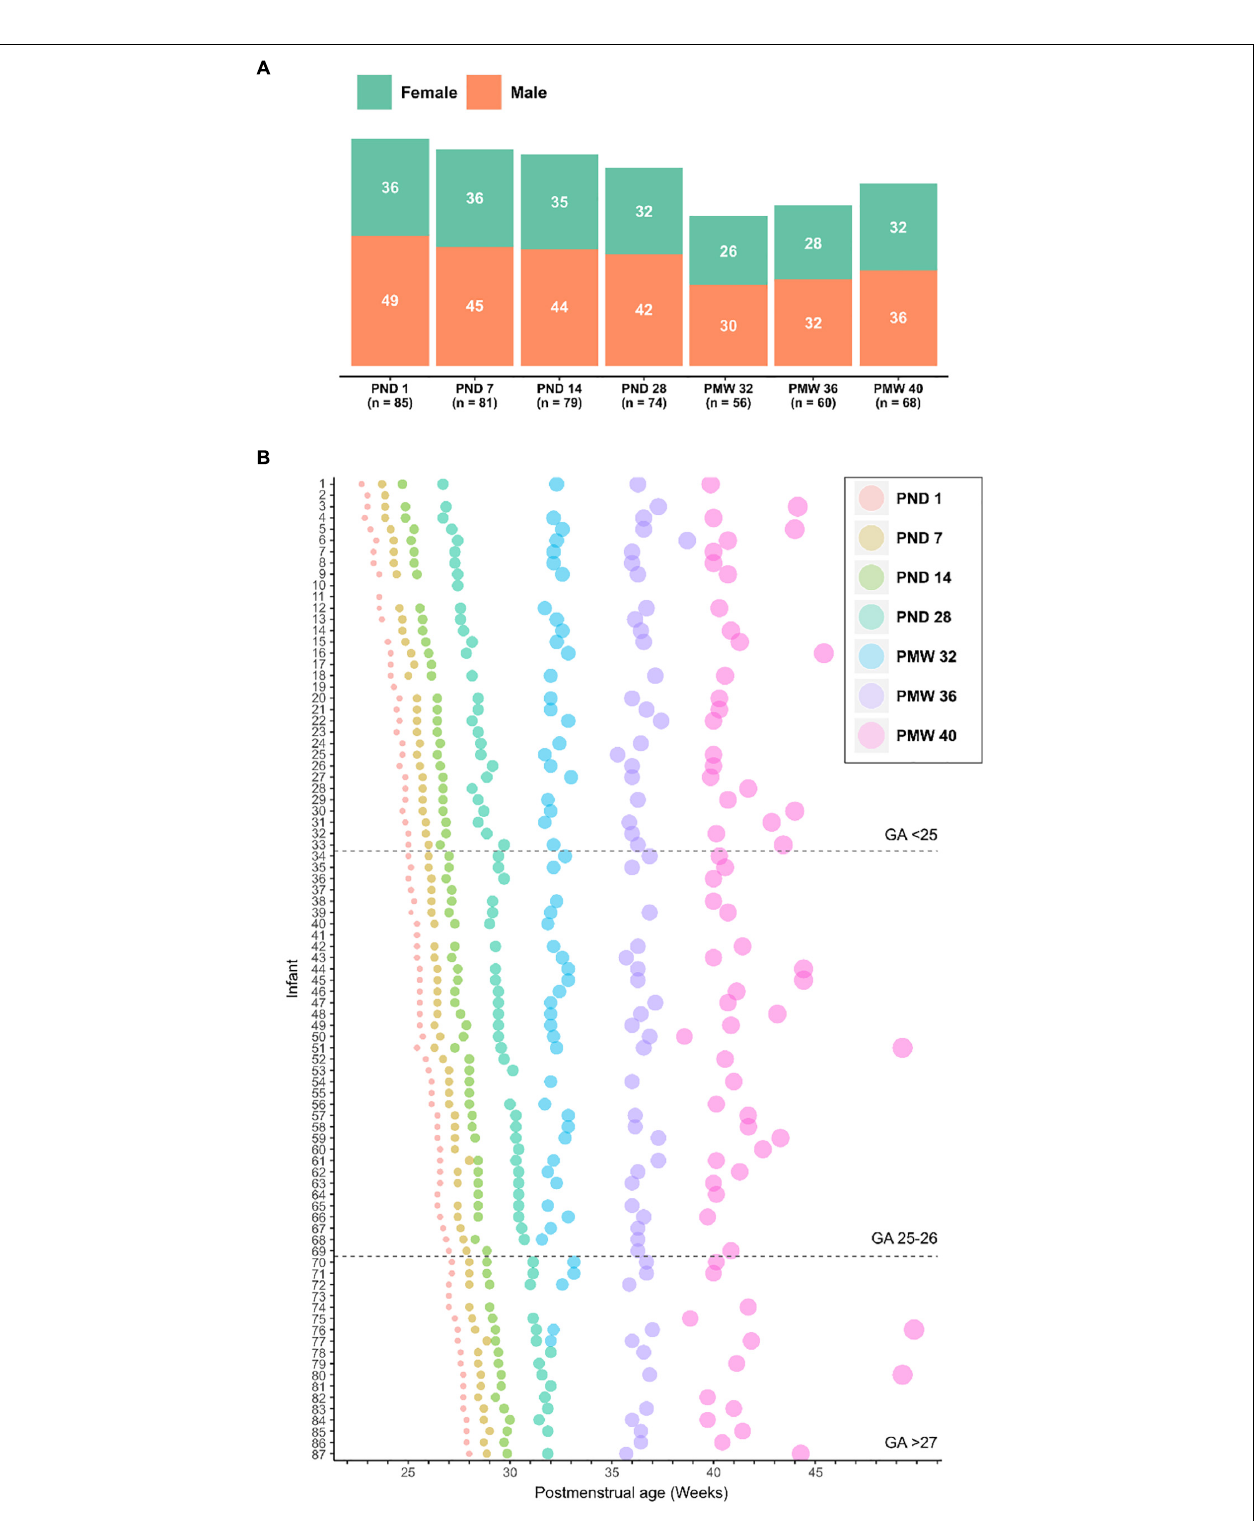
Frontiers in Neuroscience |